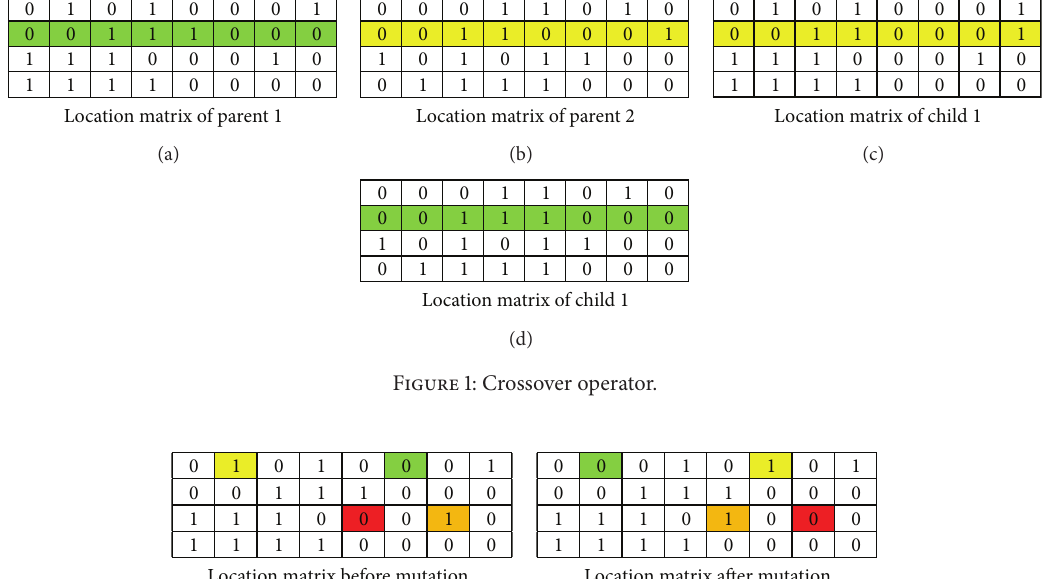
Figure 2: Mutation operator.